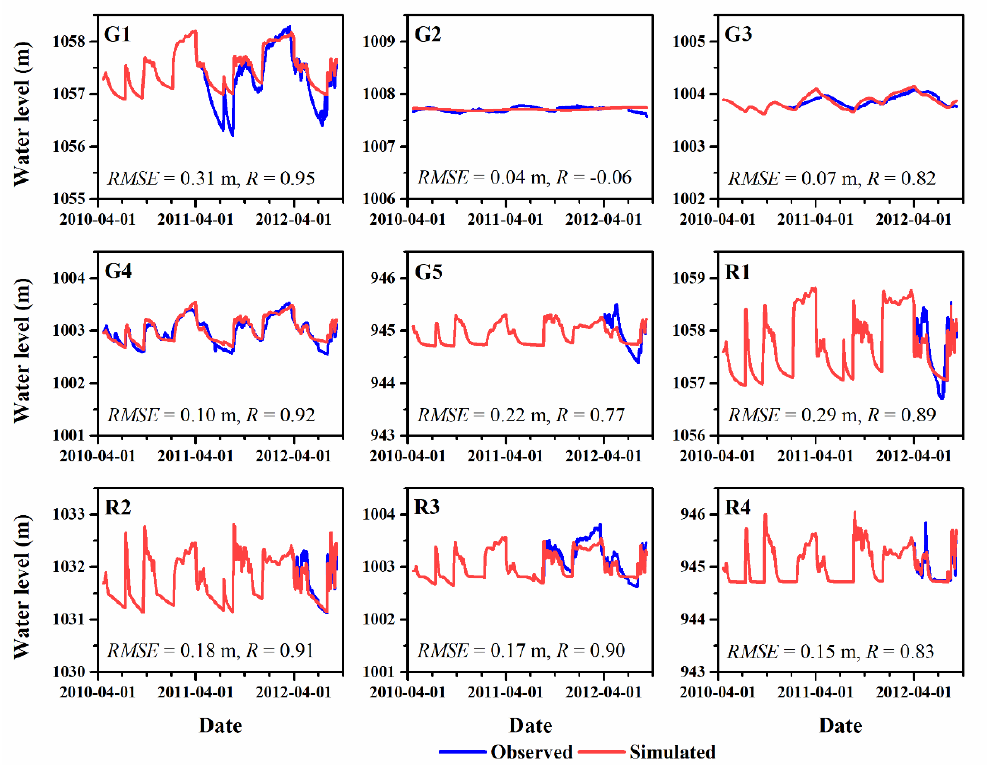
Figure 4. Simulated versus observed water levels from 21 April 2010 to 7 September 2012.